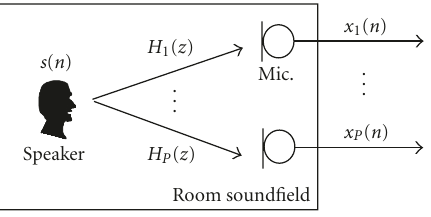
Figure 1: Single-source multimicrophone acoustic system. H i ( z ) represent room transfer